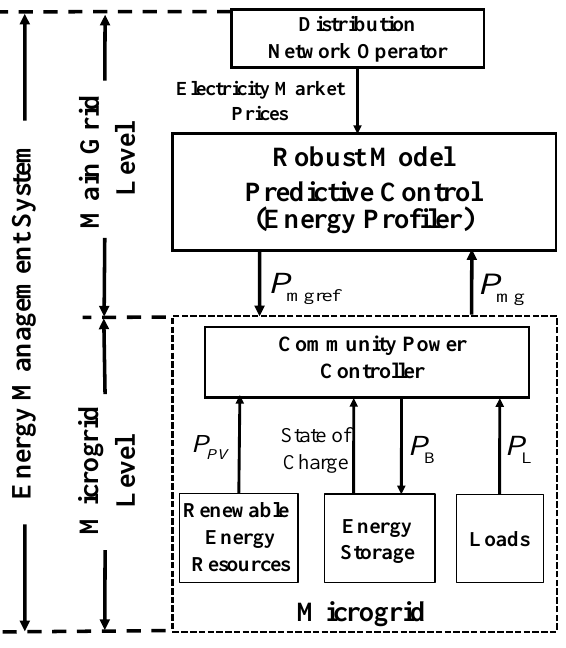
Figure 1. Hierarchical energy management system (EMS)